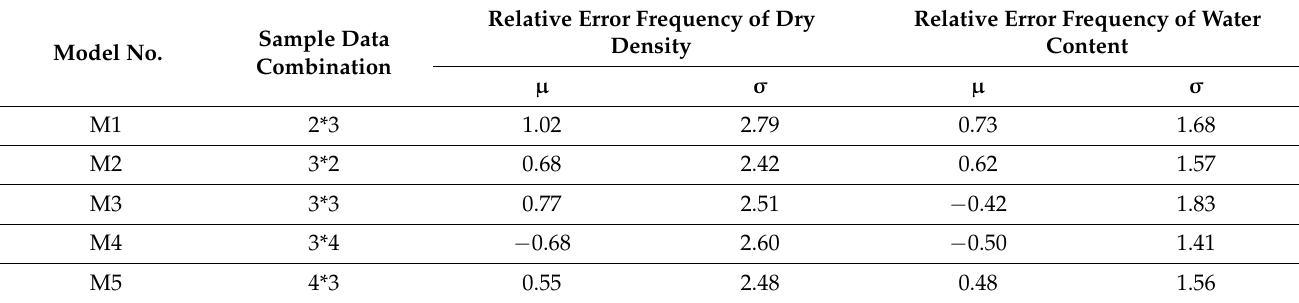
Figure 8. Statistical result chart of the relative error frequency of water content of M1. Table 8. Statistical results of the relative error frequencies of dry density and water content of M1. Model No.